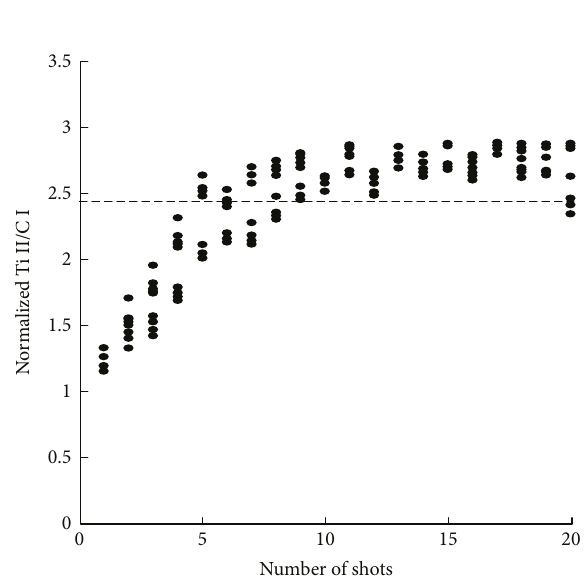
Figure 9: Evolution of multiple Ti II lines (Table 2) for a laser pulse energy of 200mJ. Each point is an average of 10 shots. The dashed line shows the sintering